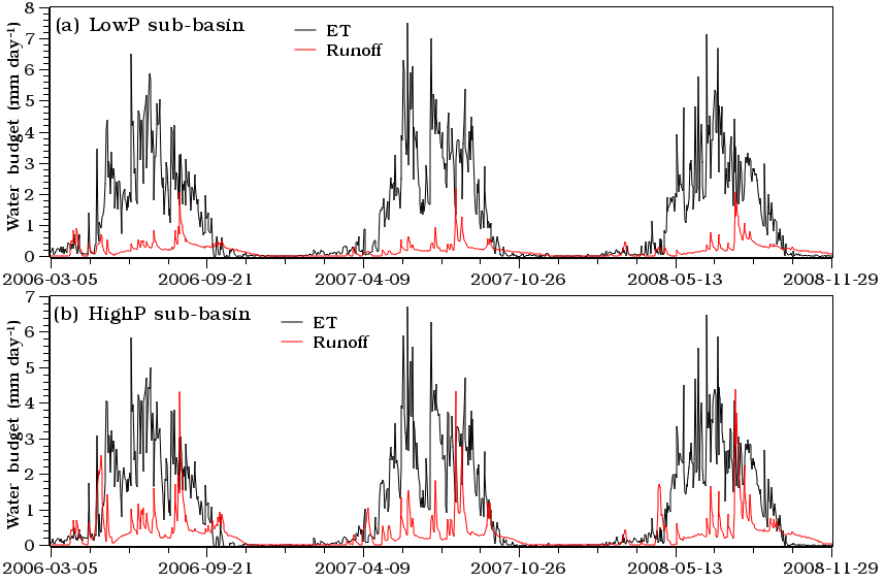
Figure 7. Comparison of evapotranspiration (ET) and runoff simulations – obtained from parameterization based on aspect parameterization (a) in the LowP sub-basin and (b) in the HighP sub-basin.